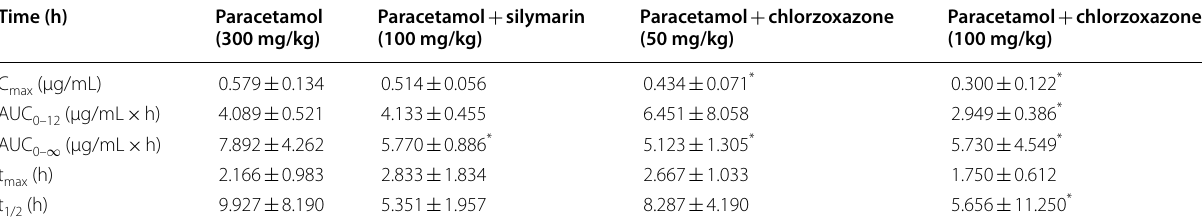
** p < 0.001, * p < 0.01 when compared to paracetamol alone group